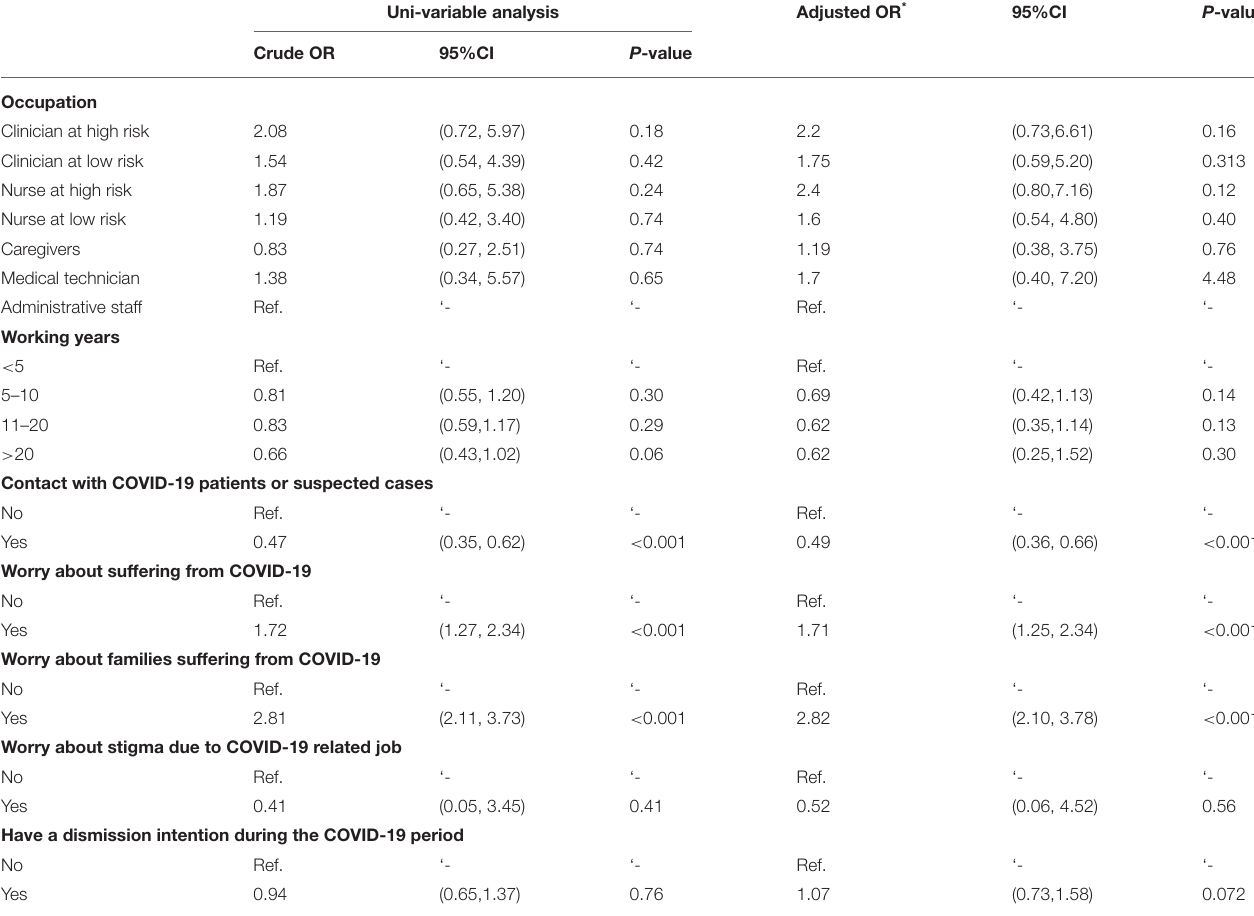
TABLE 4 | Factors associated with depression during the COVID-19 period for healthcare workers ( N = 908) in Guangdong, China. Uni-variable